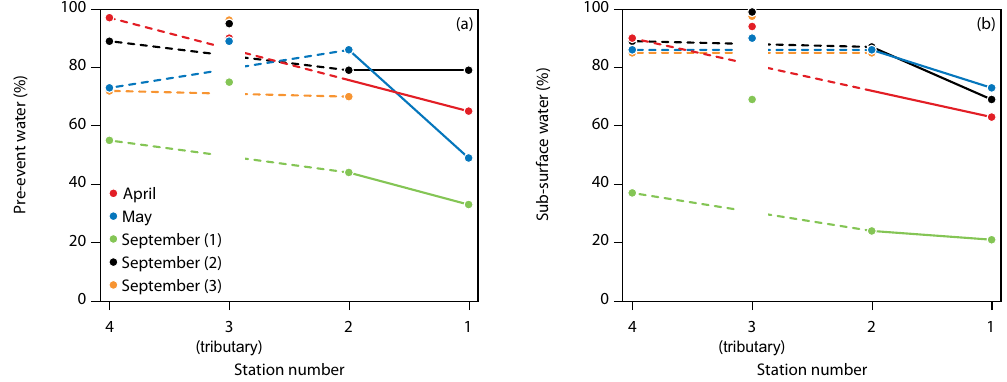
Figure 8. (a) Pre-event fractions and (b) sub-surface fractions for all events. The September event was subdivided into three sub-events and subsurface fractions calculated for the main stream. Uncertainties were less than 10% for all fractions (not